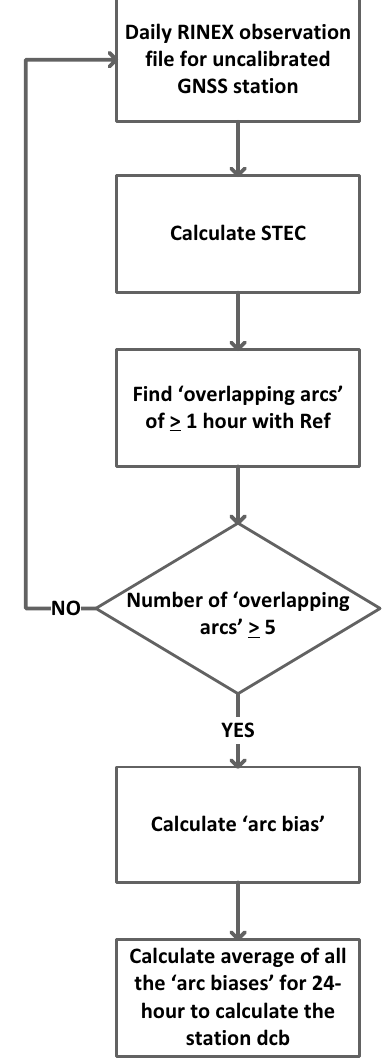
Fig. 2 Simplified block diagram for the proposed technique to calculate bias for the uncalibrated GNSS